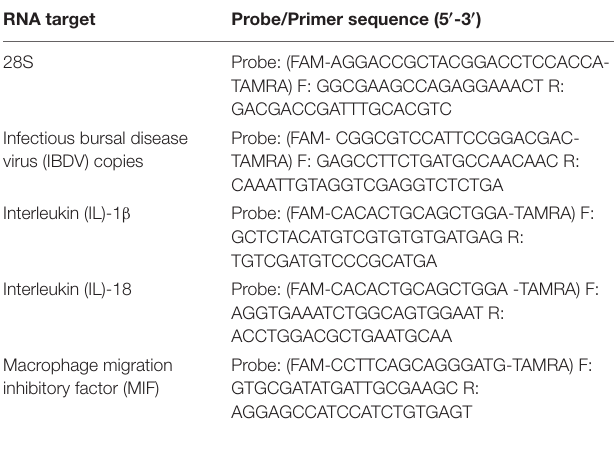
TABLE 1 | Primer and probe sequences used for quantitative polymerase chain reaction (PCR)